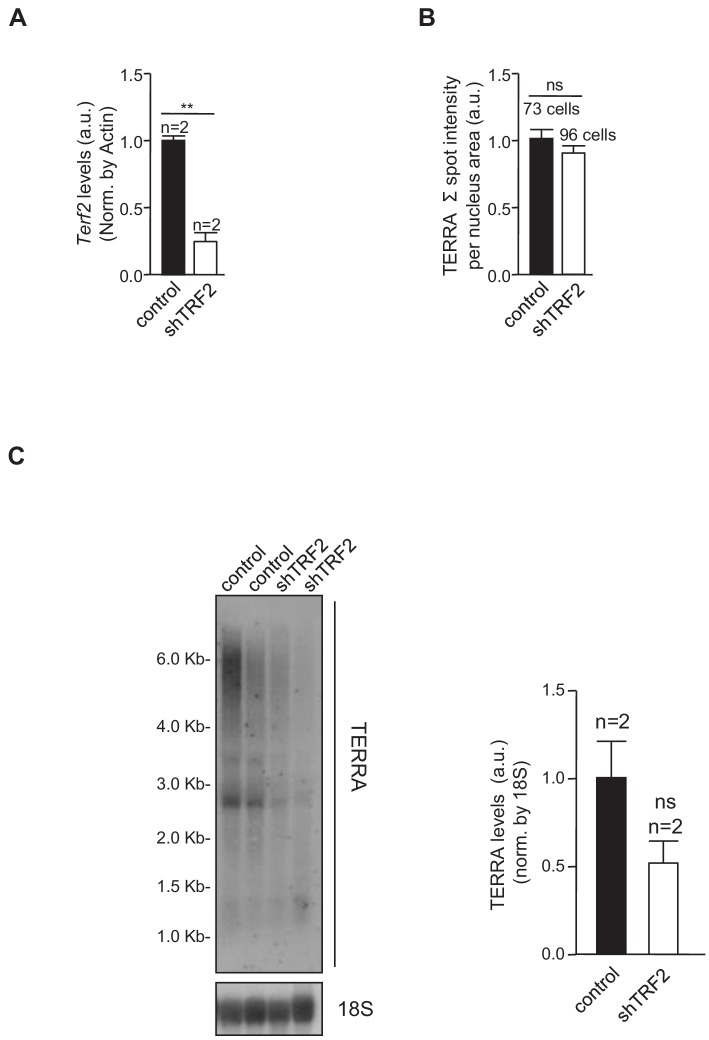
TRF2 abrogation in Trp53–/– 2i-grown iPS cells does not change TERRA levels.(A) Trf2 expression levels, as measured by q-PCR, in iPS cells infected with a scrambled (control) shRNA or an shRNA against TRF2. Note the clear reduction in Trf2 levels. N = number of independent experiments.; Error bars = SE. Statistical analysis was carried out by Student's t-test. ** = Adjusted p-value <0.001. (B) TERRA levels in control cells or cells in which TRF2 is abrogated, as measured by RNA-FISH. Note that TERRA levels do not change when TRF2 expression is reduced. N = number of cells analyzed. Error bars = SE. Statistical analysis was carried out by Student's t-test. (C) TERRA levels in control cells or in cells in which TRF2 is abrogated, as measured by Northern Blot. Note again that the depletion of TRF2 does not increase levels of TERRA RNA. N = number of independent experiments. Error bars = SE. Statistical analysis was carried out by Student's t-test.